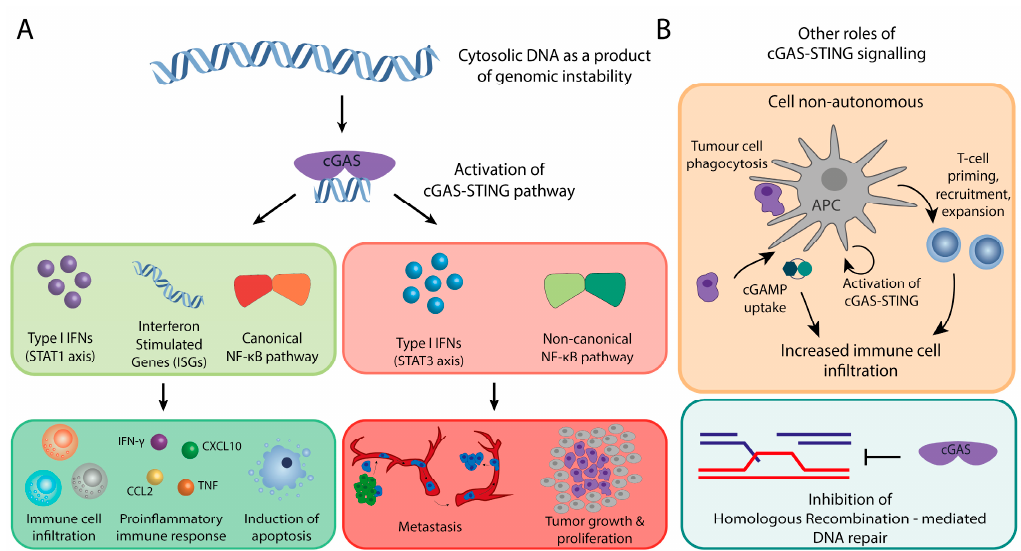
Figure 3. The two faces of cGAS-STING signaling in cancer. ( A ) cGAS-STING acts as a tumor suppressor by initiating type I interferon signaling (STAT1 axis) and canonical NF-kB signaling. These signaling axes promote immune cell infiltration and cell death in tumors through modulation of transcription of pro-inflammatory and apoptosis signaling molecules. Conversely, it also triggers the other side of type I interferon signaling, the STAT3 axis, and the non-canonical NF-kB pathway to promote metastasis and tumor growth. ( B ) Other roles of cGAS-STING signaling: (1) a cell non-autonomous role in which cancer cells’ DNA is engulfed by antigen presenting cells (APC) leading to activation of cGAS-STING signaling and cGAMP production in APCs. cGAMP is secreted by the APCs further stimulating immune infiltration (upper panel). (2) Nuclear cGas can also act as an inhibitor of homologous recombination-mediated DNA repair (lower panel).